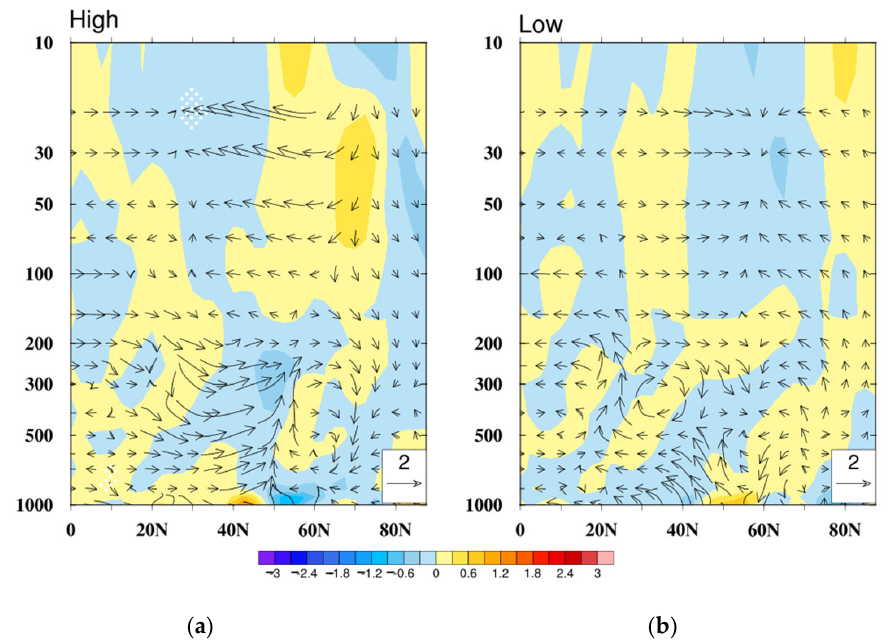
Figure 11. EP flux (arrow) and divergence (shading) in winter of ( a ) HSAYs and ( b ) LSAYs. Stippling indicates the grid points that passed the 0.1 significance test). Units: latitude is °N, and the vertical pressure is hPa).